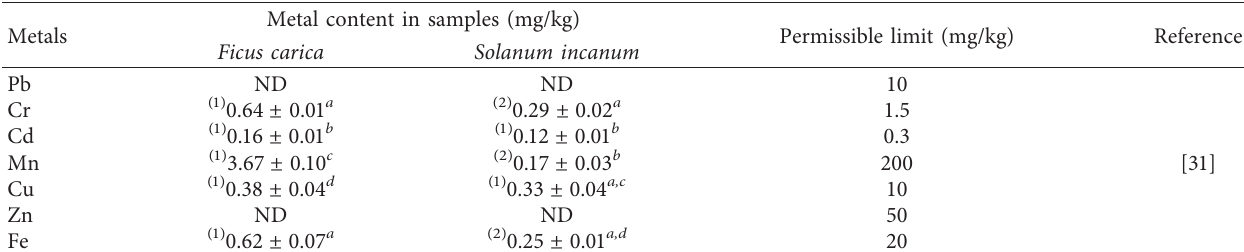
Table 8: Heavy metal levels in the respective plant materials determined by